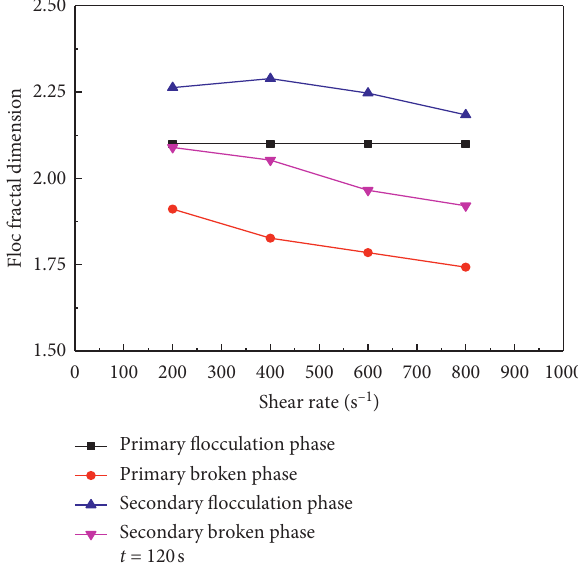
Figure 11: The variation of floc fractal dimension with a shear rate in the four phases (shear time �